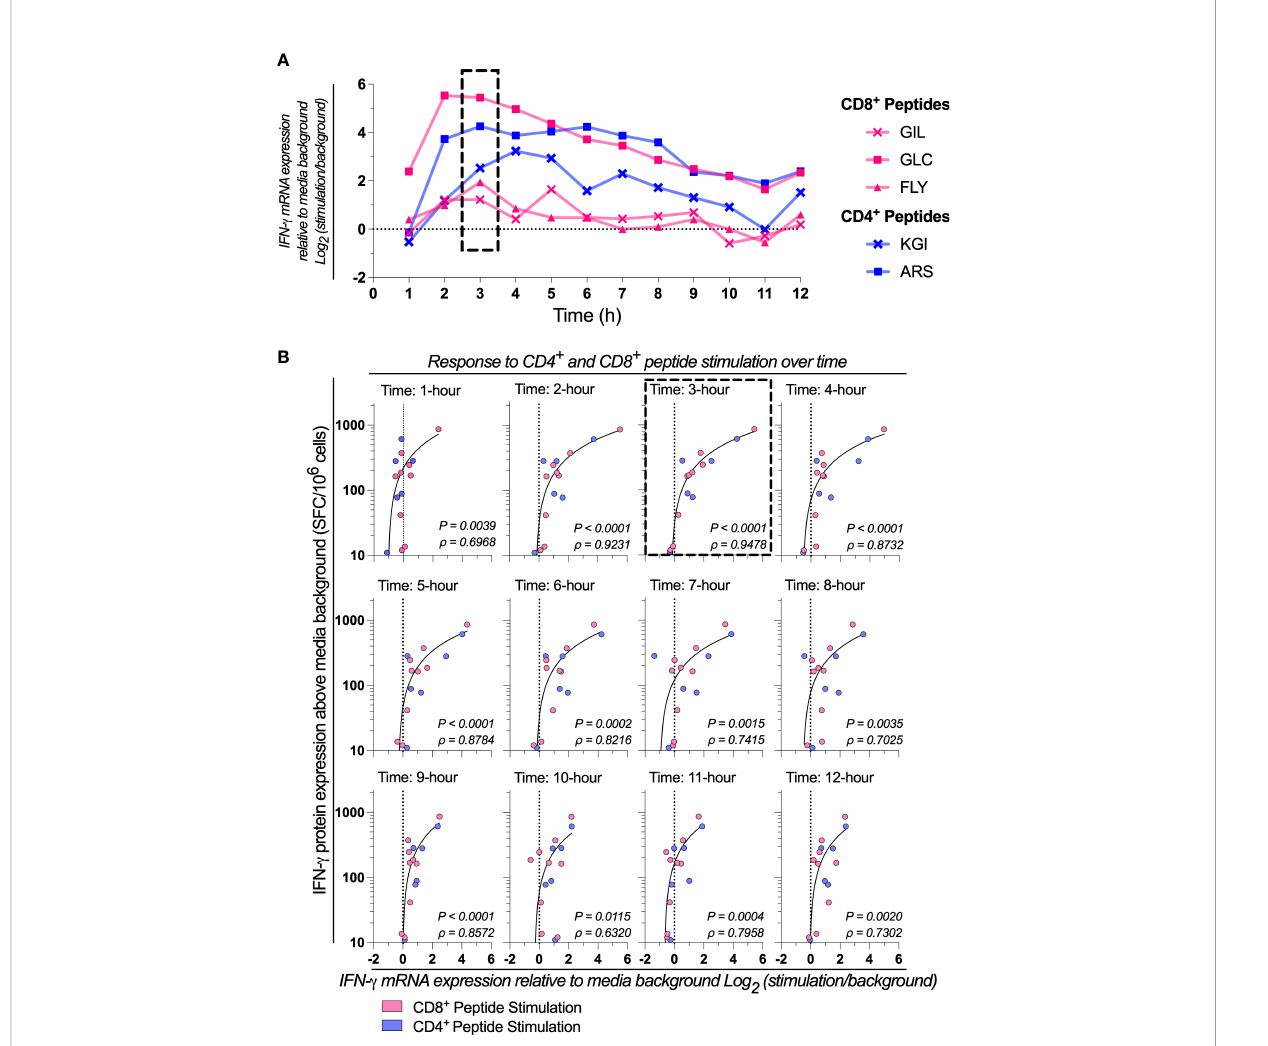
FIGURE 2 Response to CD4 + and CD8 + peptide stimulation over time. (A) IFN- g mRNA expression by absolute-quantitative HTS-optimized RT-qPCR in response to stimulation with two CD4 + (In fl uenza 57-71 KGI and In fl uenza 260-284 ARS) and three CD8 + (In fl uenza 58-76 GIL, Epstein Barr Virus 356- fi ned T cell epitopes across 1-12 hours post-stimulation. Shown is a 364 FLY and Epstein Barr Virus 280-288 GLC) peptides representing well-de representative sample. (B) IFN- g mRNA expression by RT-qPCR correlated to IFN- g protein production by ELIspot in response mRNA expression. Single RNA extractions, with single reverse transcription reactions per n (n=3) per stimulation were performed, with qPCR and ELIspot performed in technical triplicate. Technical mean of gene copy number or spot forming cells (SFC) corrected for background are shown. The strength of the association between RT-qPCR IFN- g mRNA gene expression and ELIspot IFN- g protein expression was tested by Pearson ’ s correlation on log transformed data. ELIspot data <10 SFC/10 6 were graphically omitted. The 3-hour timepoints are highlighted (dashed box). P values and Pearson ’ s correlation coef fi cient ( r )